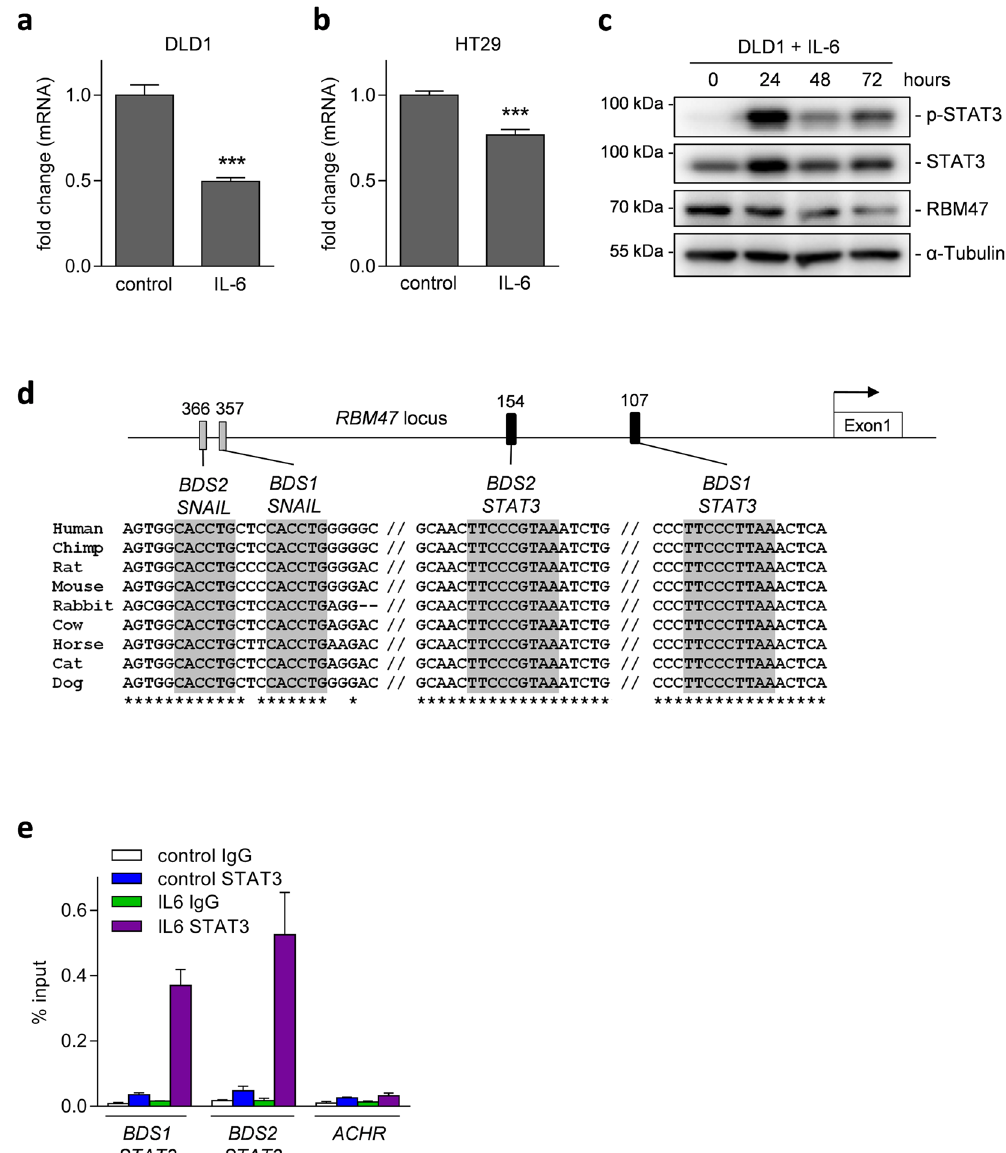
Figure 5. Direct suppression of RBM47 by IL-6 activated STAT3. ( a and b ) Expression of RBM47 mRNA in ( a ) DLD1 or ( b ) HT29 CRC cells after treatment with IL-6 (20 ng/ml) or vehicle for 72 hours. ( c ) Western blot analysis of indicated proteins in DLD1 cells after exposure to IL-6 (20 ng/ml) for the indicated periods. ( d ) Map of the human RBM47 promoter region with the indicated conserved STAT3 and SNAIL binding sites. Filled rectangles represent the binding sites. TF binding sequence motifs are indicated by grey shadowing. Their conservation between species is indicated by asterisks. The arrow indicates the TSS, // represent additional, not shown sequences between the BDS. ( e ) qChIP analysis of STAT3 occupancy at the RBM47 promoter and, as a control, the acetylcholine receptor ( ACHR ) locus in DLD1 cells treated with vehicle or IL-6 for 20 minutes. In a,b, and e mean values ± SD (n = 3) are provided with * P < 0.05; ** P < 0.01; *** P <